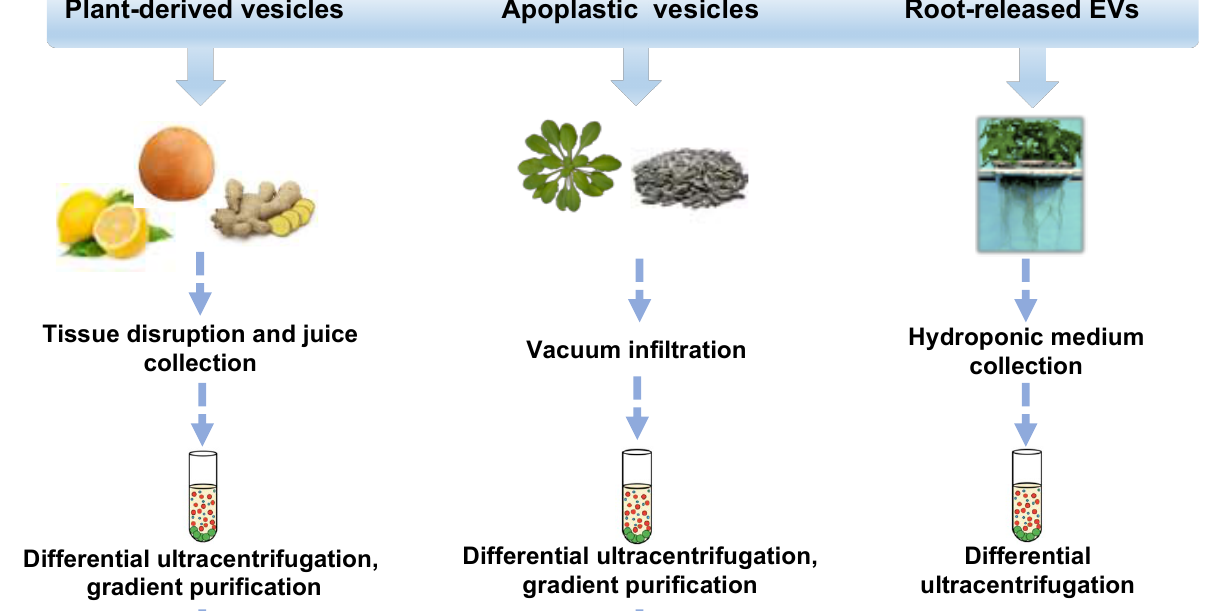
Figure 1. Isolation strategies and classification of plant-derived nano and microvesicles (PDVs). Overview of isolation methods and main types of plant vesicles (general plant-derived vesicles, apoplastic vesicles, and root-released vesicles) based on the plant source from which they derive (fruits or rhizomes, seedlings or seeds, and roots). Plant vesicles could be isolated trough differential ultracentrifugation steps and associated gradient purifications.